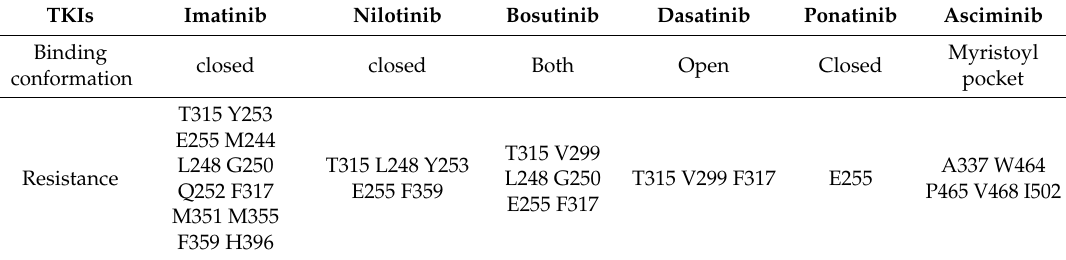
Table 2. TKI − resistant mutations observed in patients with chronic myeloid leukemia